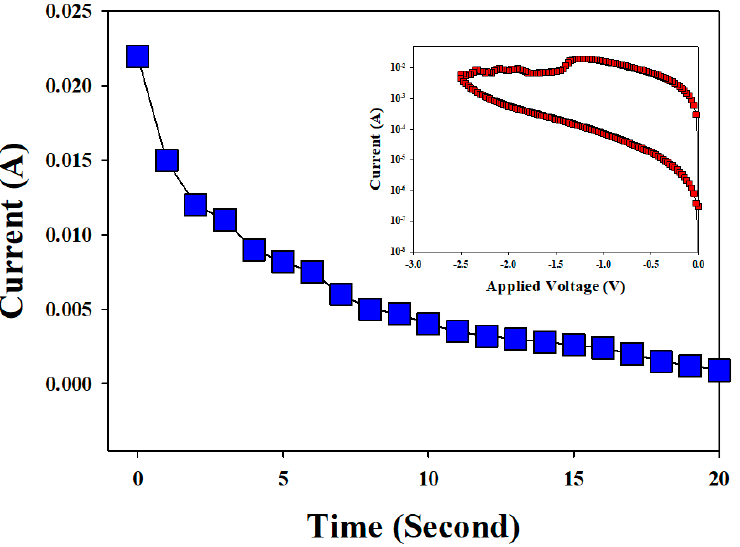
Figure 5. The reaction time ( S ) versus the electron charge of unit current ( A ) curves in reset state of the vanadium thin film RRAM devices for − 1.5-2.5 V.